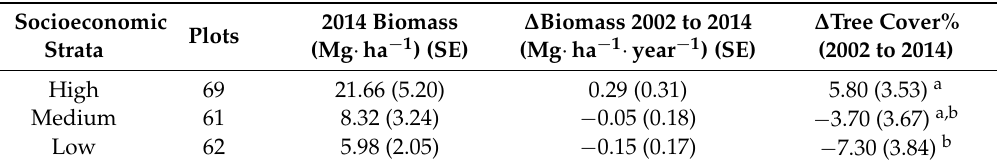
Table 3. Mean aboveground tree biomass in 2014, change in aboveground tree biomass ( ∆ Biomass), and mean percent tree cover change ( ∆ Tree Cover%) according to socioeconomic strata during 2002 to 2014 in Santiago, Chile.